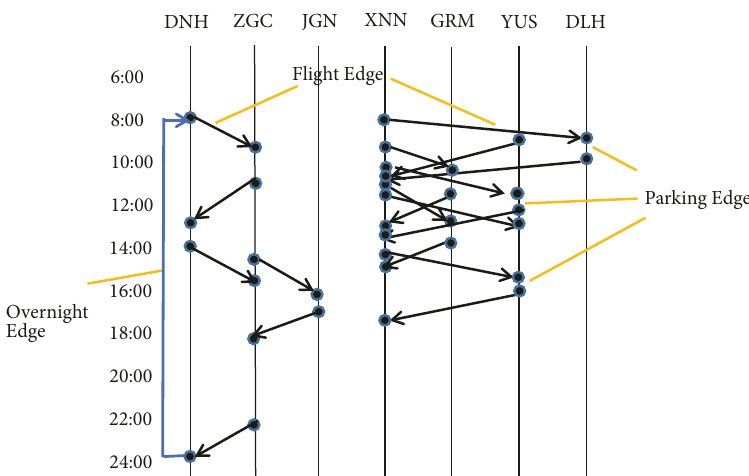
Figure 2: The time-space network diagram of flight schedule of the Lanzhou control area